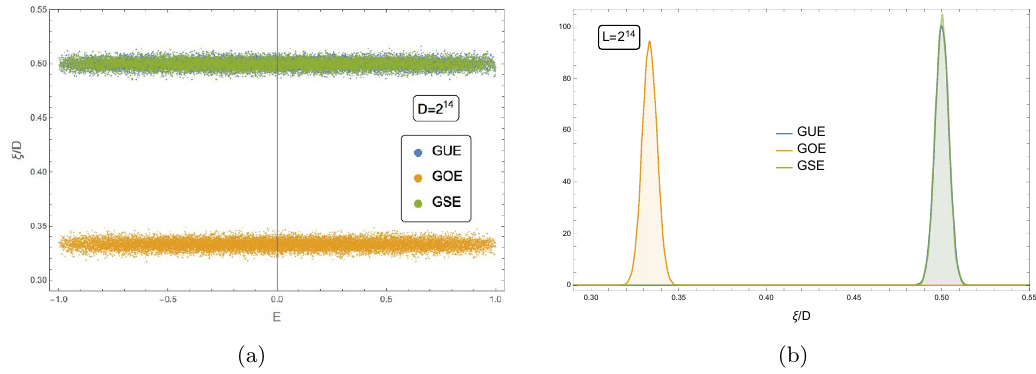
Figure 8 . Left: the distribution of the normalized IPR of the GUE, GOE and GSE of dimension D = 2 14 versus the normalized energy E . The distributions of the GUE and GSE overlap. Right: the distribution of the normalized IPR of the GUE, GOE and GSE of dimension D = 2 14 . The normalized IPR of GUE, GOE and GSE follows a Gaussian distribution with mean (cid:25) 0 : 500 ; 0 : 333 and 0 : 500 and deviation (cid:25) 0 : 00394 ; 0 : 00423 and 0 : 00385, respectively.